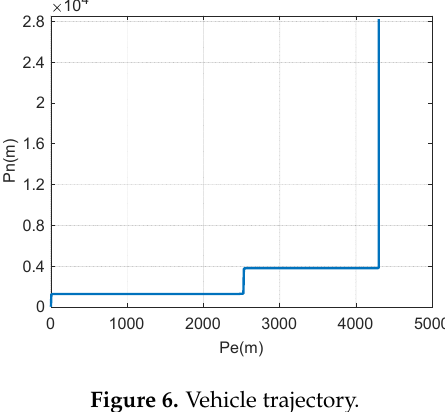
Figure 6. Vehicle trajectory.